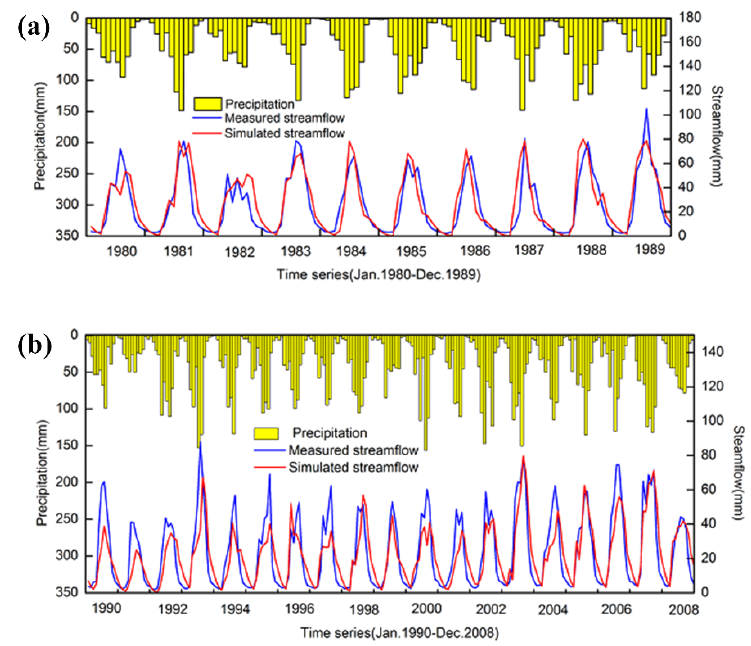
Figure 4. Comparison between the measured and simulated streamflow in different periods. ( a ) 1980–